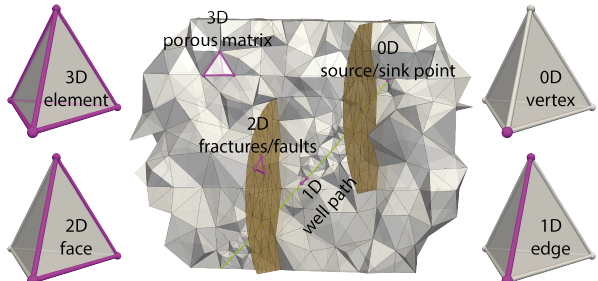
Figure 1. Schematic representation of the approach to model frac- ture rock masses as based on a superposition of lower- and higher- dimensional geometric elements, after Cacace and Blöcher (2015): 0-D vertex (point-like sources/sinks), 1-D edge (well paths), 2-D face (fractures an faults), and 3-D element (porous matrix).